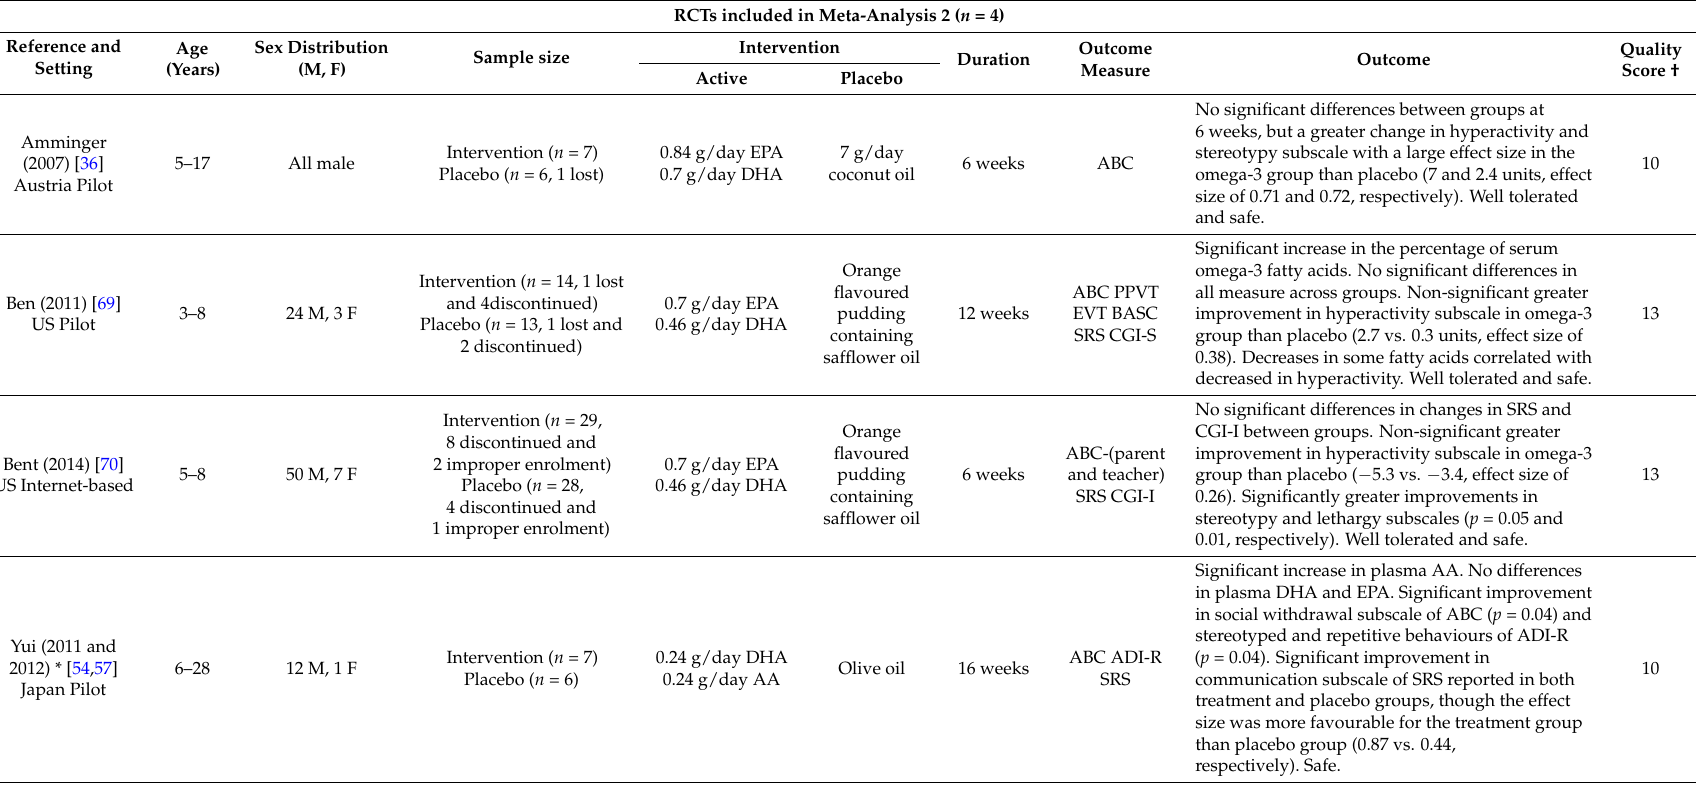
Table 2. Study characteristics of randomised controlled trials (RCTs) included in systematic literature